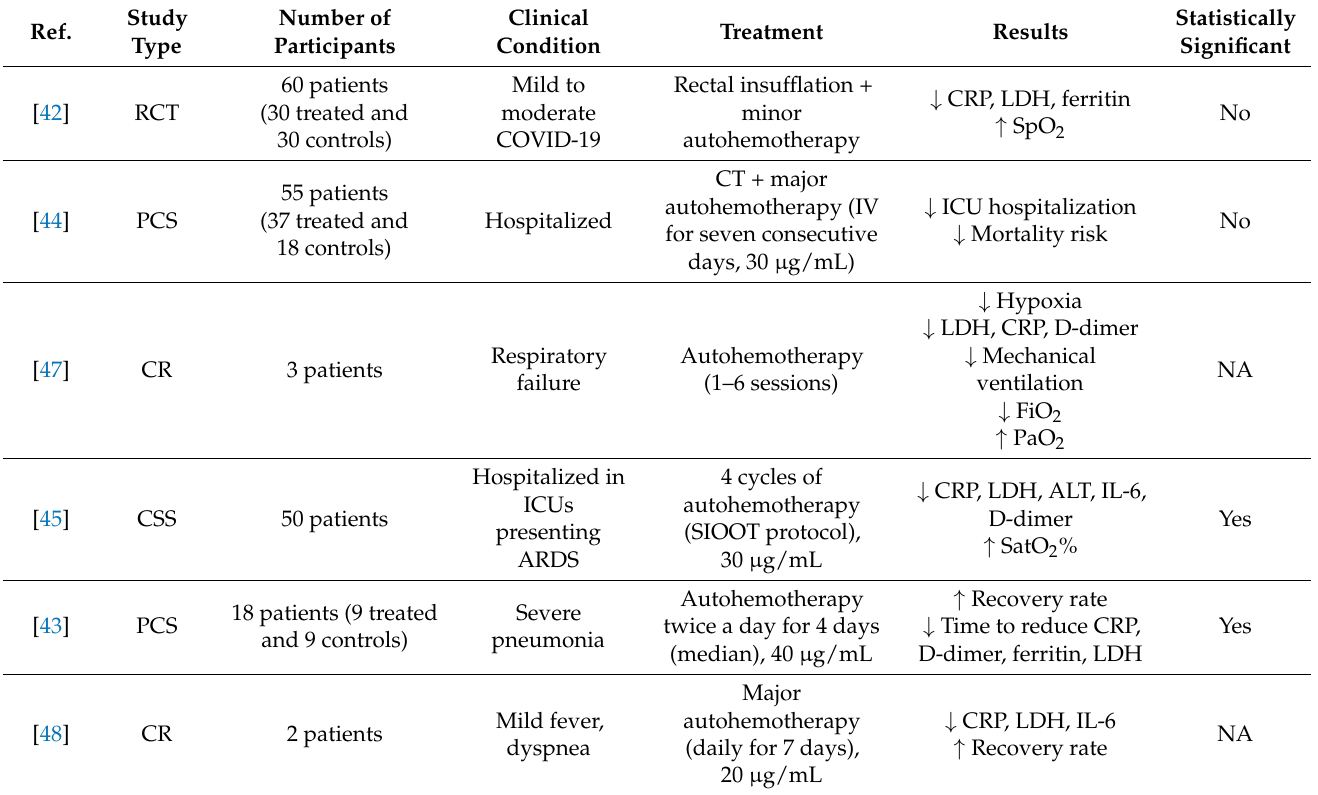
Table 1. Clinical evidence for the use of medical ozone in COVID-19 treatment.